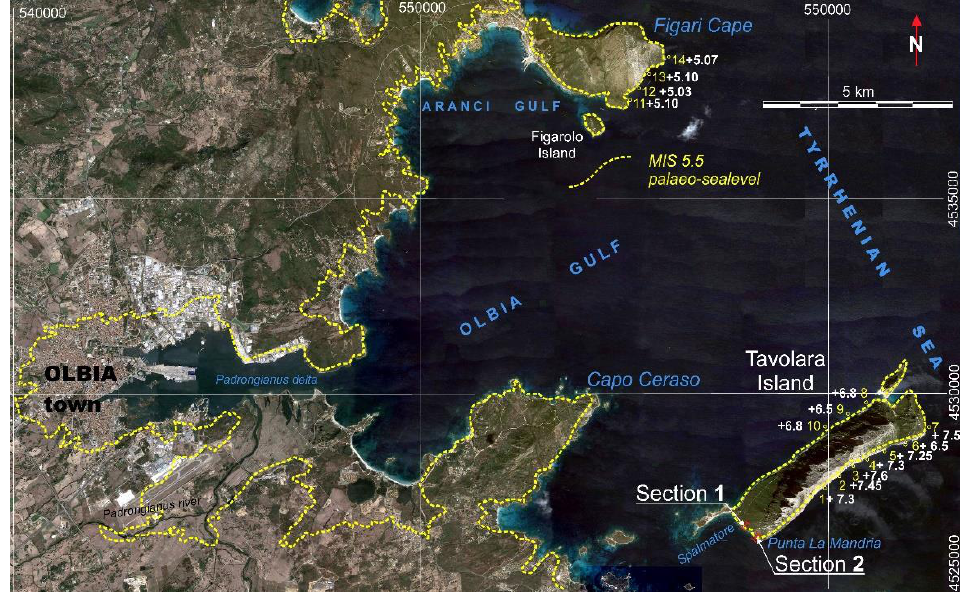
Figure 9. Aerial photograph of the coastal plain and the Gulf of Olbia, between the Figari Cape to the north and the Tavolara Island to the south, yellow dashed line indicates the paleo high sea level of MIS 5.5. Location of MIS5 stratigraphic sections (Figure 10): Section 1, on the Tavolara Island, east coast of the bay of Spalmatore. Section 2, near the promontory of Punta La Mandria, southernmost point of the Tavolara Island and elevations of the tidal notch of the MIS 5.5 [39].